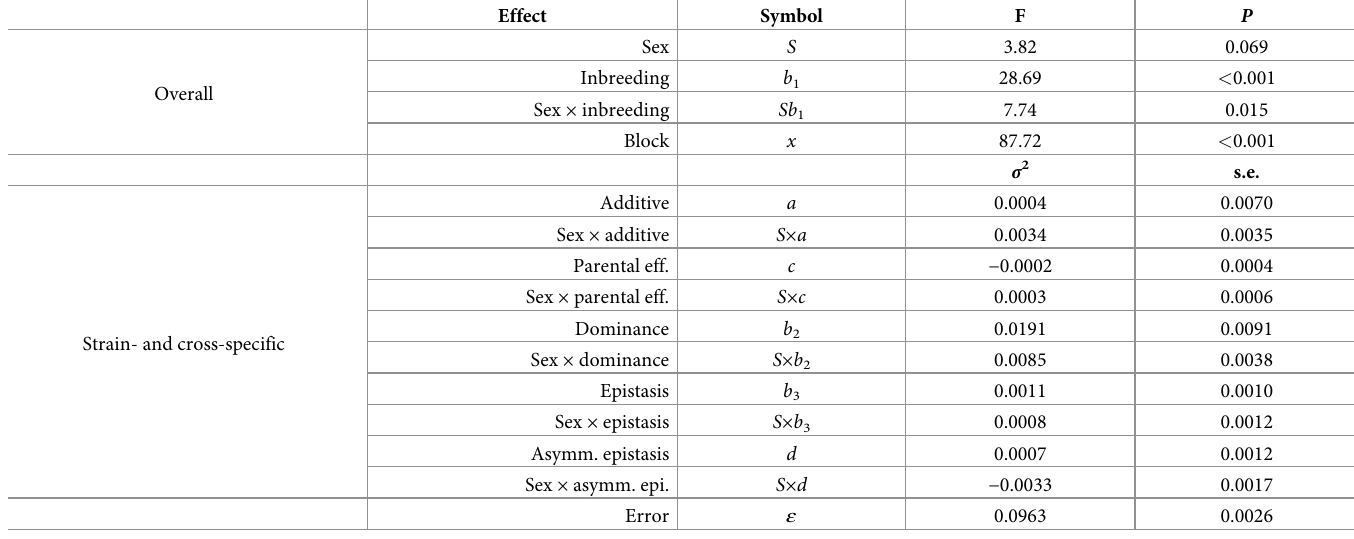
Table 1. Results of the full sexed REML model. F statistics with P values for the overall (fixed) effects and variances ( σ 2 ) with s.e. for strain- and cross-specific (random) effects (i.e., variance